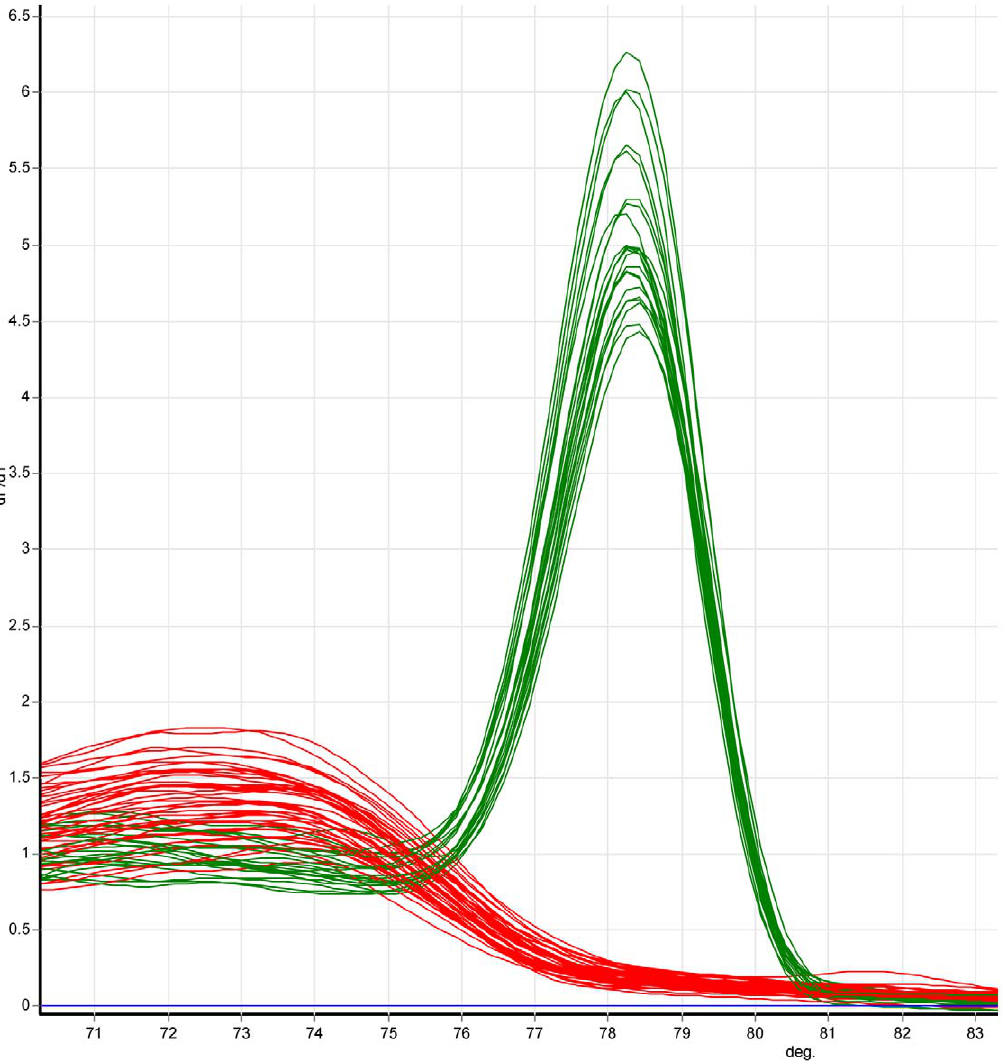
Figure 2. Marker typing in the BAC-range panel by MT-PCR-HRM. Each individual marker, which is uniquely amplified from genomic DNA, is mapped by genotyping in the mapping panel of 88 aliquots (Fig. 1b,f). This MT-PCR-HRM typing identifies the aliquots within the panel that are positive (green) or negative (red) for a particular marker by melting curve analysis using a fluorescent dye. If the PCR product is present in aliquots, the ‘positive’ green trace is detected and scored as 1. The absence of PCR product in aliquot (red line) is scored as 0. With a series of 1 and 0 for all aliquots in the panel, the marker is scored.